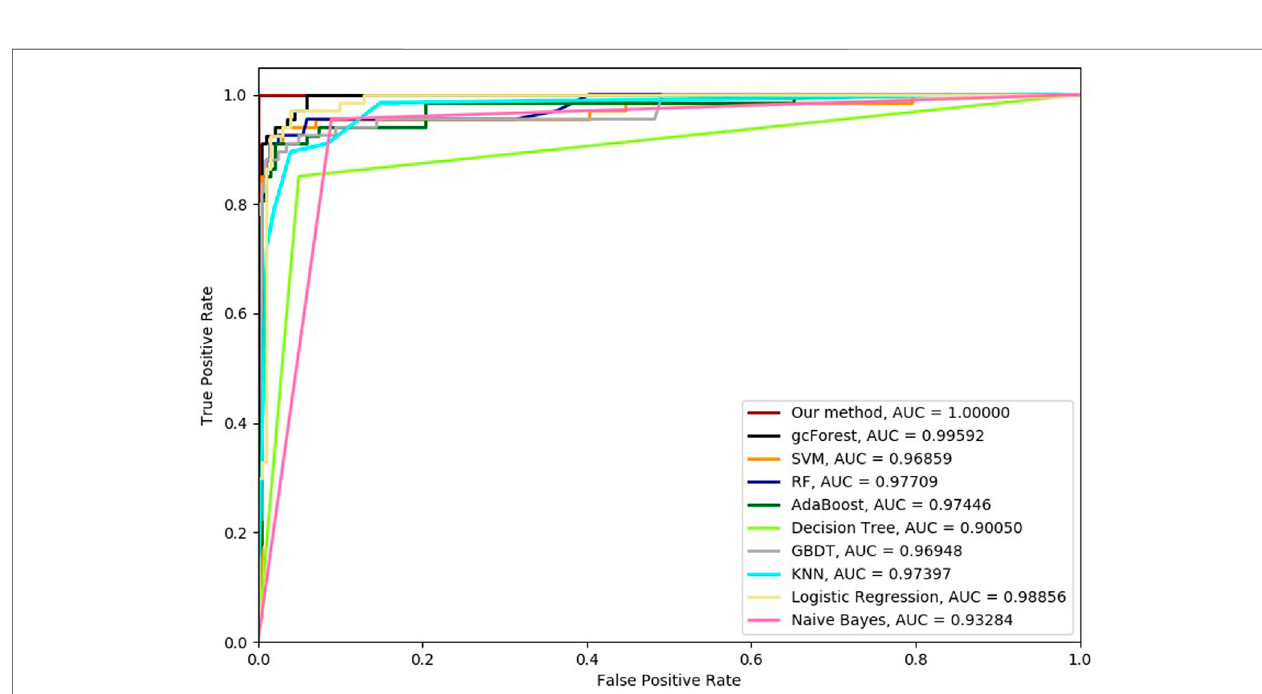
FIGURE 9 | Hypertension-related compound identi fi cation performances of ten methods with 15-cross validation methods.